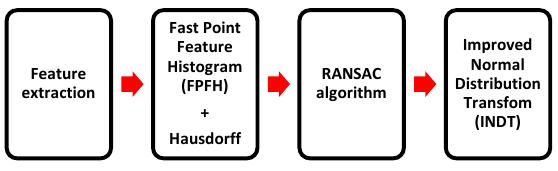
Figure 5. FEM processing